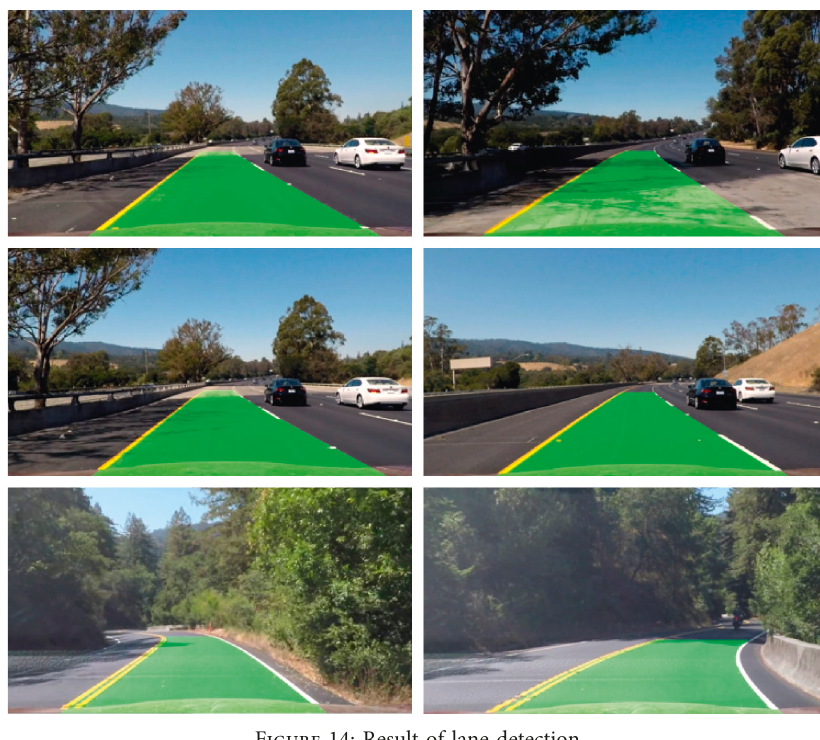
Figure 14: Result of lane detection.